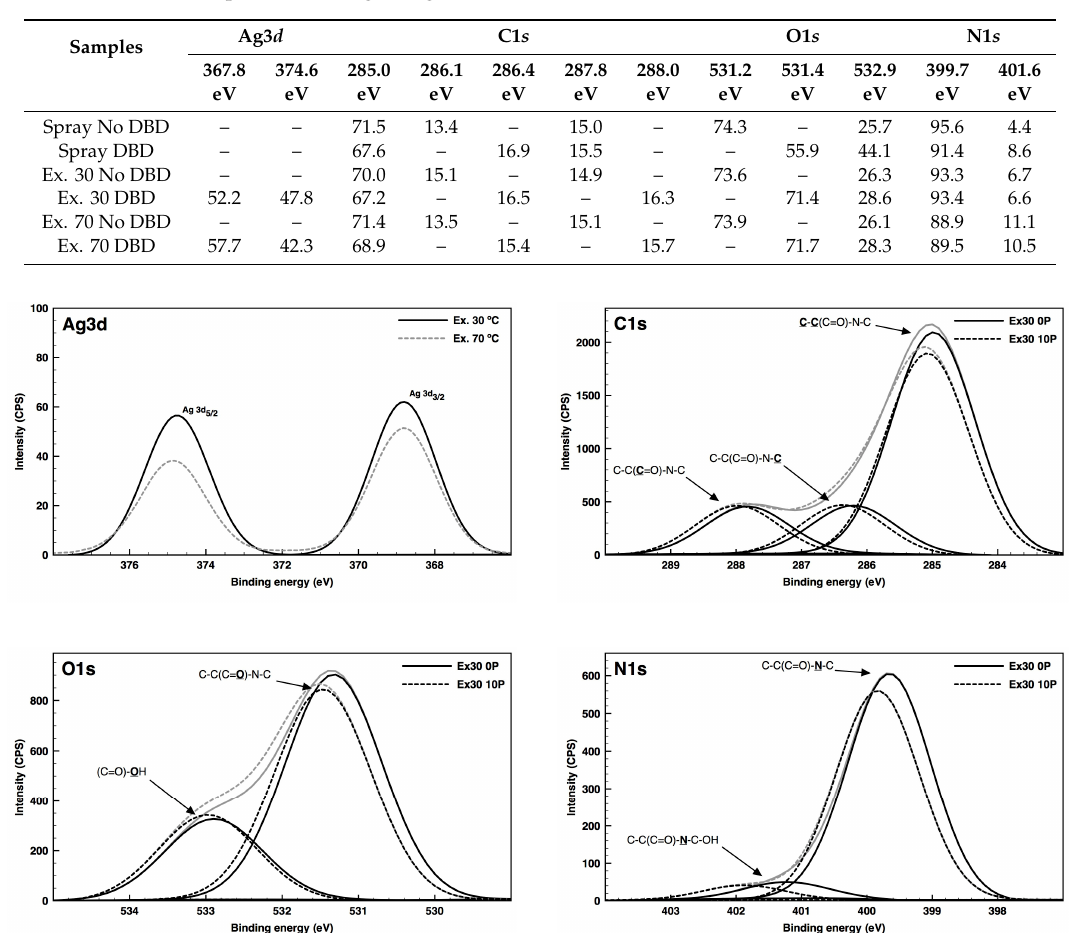
Table 2. Results of the deconvolution analysis of the C1 s , N1 s , O1 s and Ag3 d peaks for the untreated and DBD plasma-treated PA66 fabrics with AgNPs deposited with spray and exhaustion at 30  C and 70  C methods. Reported binding energies have an associated error of ±0.1 eV.